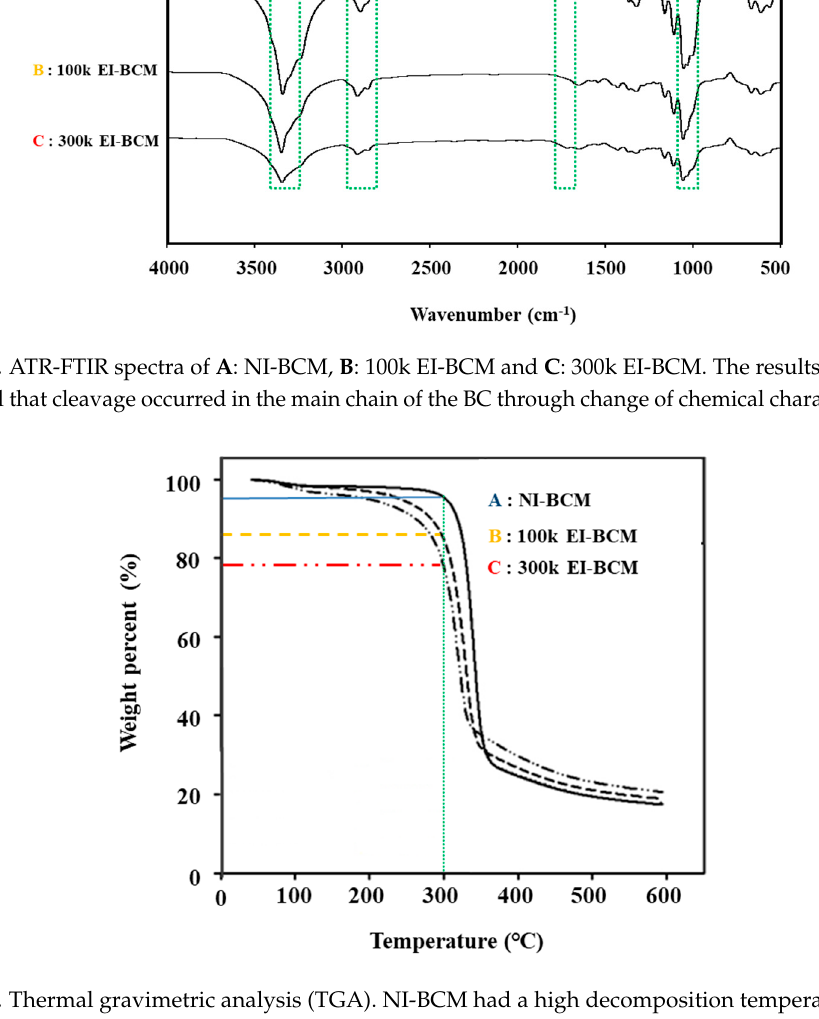
Figure 4. Thermal gravimetric analysis (TGA). NI-BCM had a high decomposition temperature near 300 °C. As radiation dose increased, weight loss rates increased ( A : NI-BCM, 7%; B : 100k EI-BCM, 15%; and C : 300k EI-BCM, 22%).